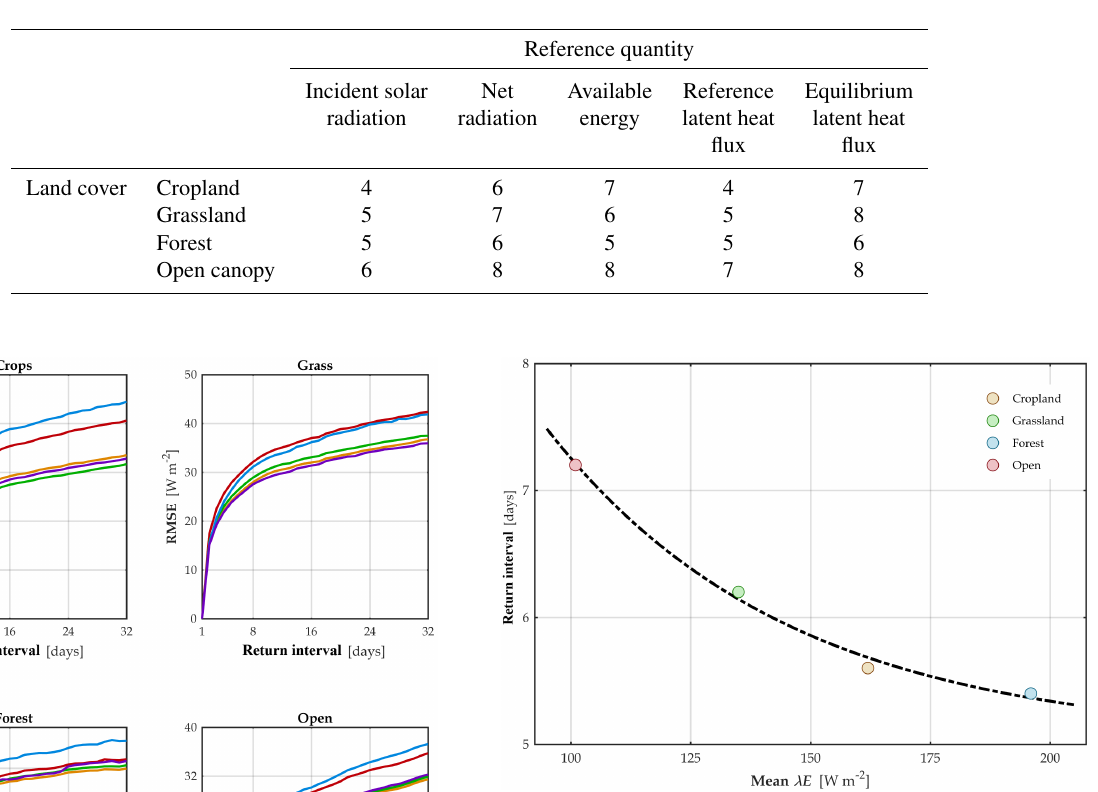
Table 2. The maximum return interval with a relative error of less than 20% is given for each reference quantity and LULC when linear interpolation was used.